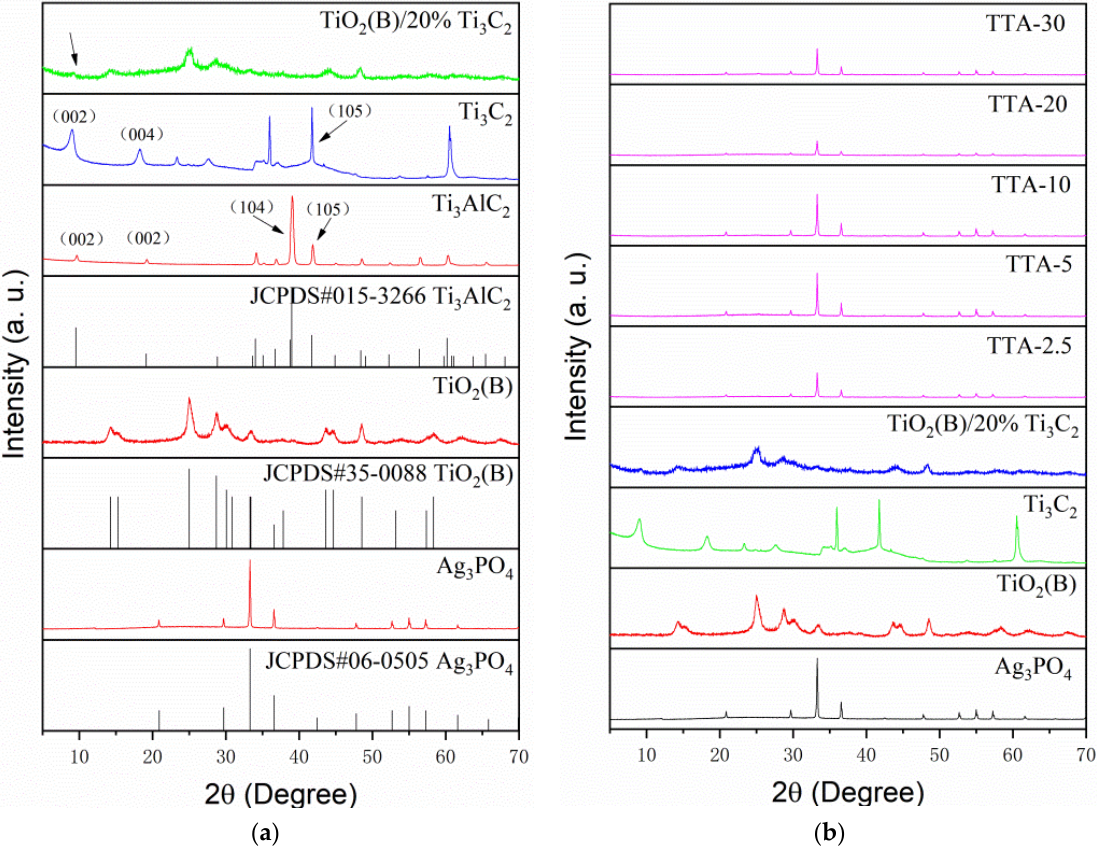
Figure 1. ( a ) XRD diffraction patterns of Ag 3 PO 4 , TiO 2 (B), Ti 3 AlC 2 , Ti 3 C 2 and TiO 2 (B)/20%Ti 3 C 2 ; ( b ) XRD diffraction patterns of TTA-2.5, TTA-5, TTA-10, TTA-20 and TTA-30.